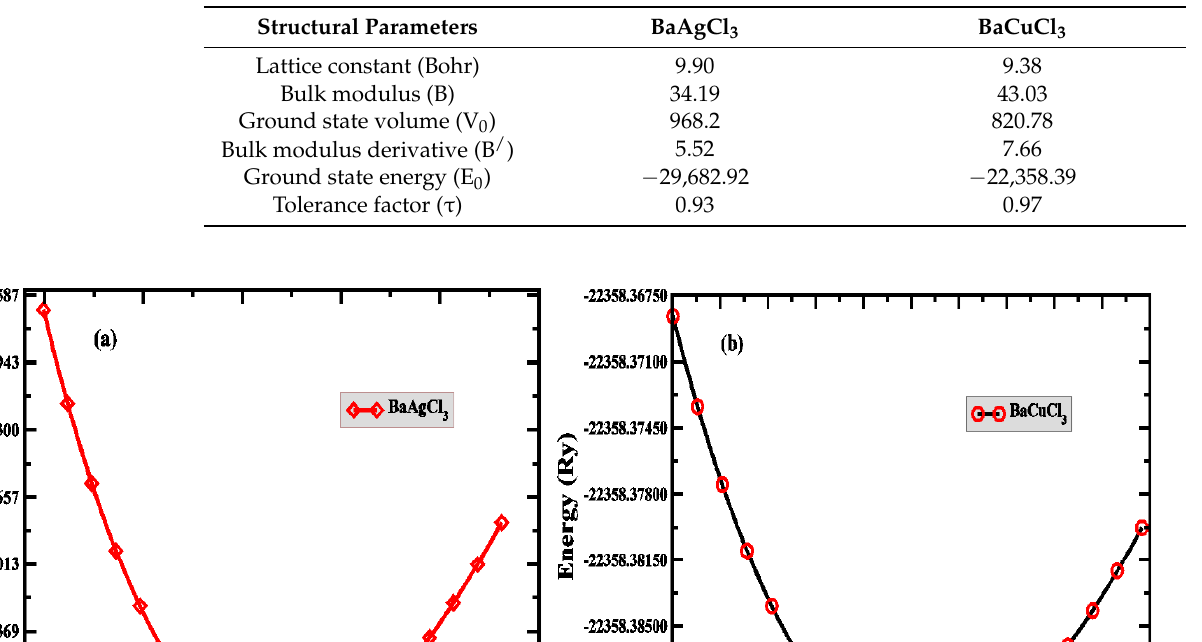
Table 1. The optimized crystal structural parameters comprising lattice constant (in Bohr), Bulk modulus (in GPa), ground state volume in (Bohr) 3 , B / (the derivative of Bulk modulus in GPa), ground state energy E 0 in Ry and the tolerance factor τ .